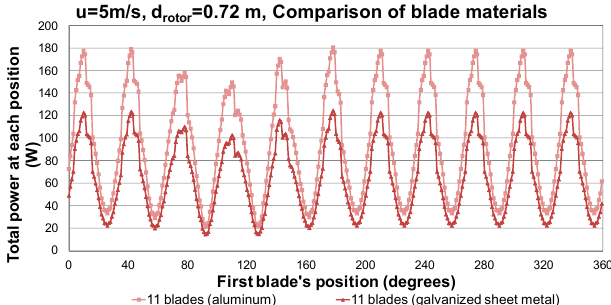
Figure 5. Total power at each blade’s position, for eleven rotor blades made of aluminum or galvanized sheet metal.